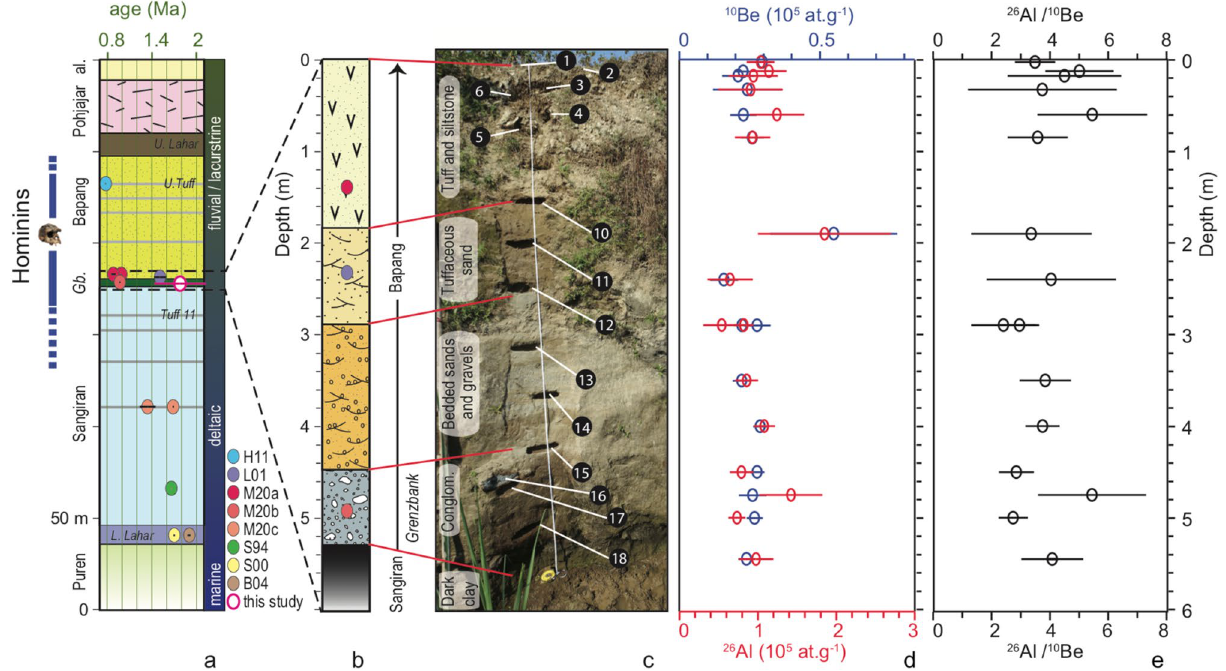
Figure 2. Bukuran sampling site, stratigraphic setting, and analytical results. ( a ) General lithostratigraphy of the Sangiran Dome 15,22,35 , depositional environment, and available datings † . Blue bars indicate proven occurrence of H. erectus fossils remains, skull is Sangiran-17 23 . ( b ) Stratigraphic log of the sampling site. ( c ) Sampling site, lithologies, and sample location (labeled by their sample name suffix: 1 is SAN18-1). The Bukuran stream flows at the bottom of the outcrop. ( d,e ): 10 Be and 26 Al concentrations and 26 Al/ 10 Be ratios over depth. Red and blue dots are 26 Al and 10 Be concentrations (S.I. Table 1). L. Lahar : Lower Lahar ; U. Tuff : Upper Tuff ; al.